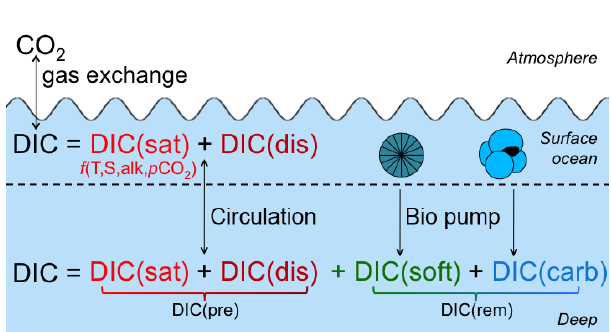
Figure 1. Illustration of the decomposition framework used for DIC in this paper. In the surface ocean, DIC is equal to DIC pre = DIC sat + DIC dis . Carbon taken up by biological processes in the sur- face ocean sinks and remineralizes in the water column to add two additional components at depths: DIC rem = DIC soft + DIC carb